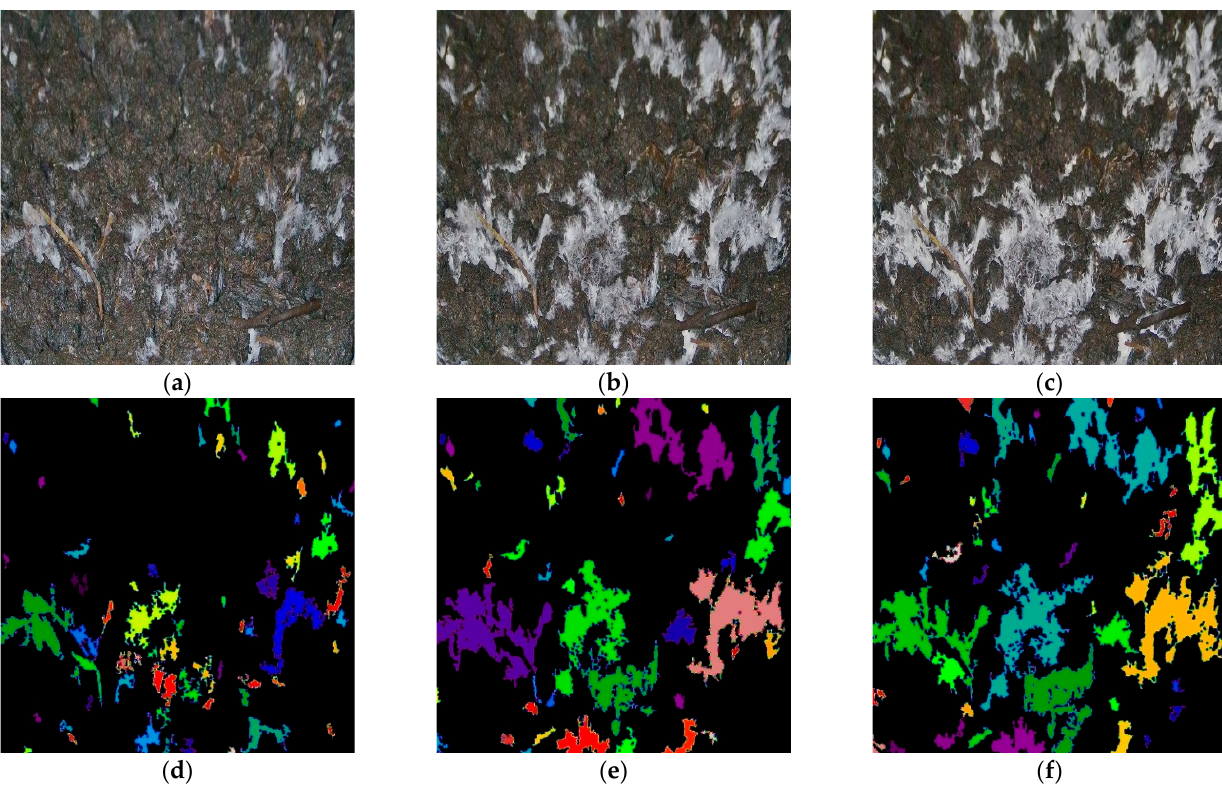
Figure 7. Grayscale images ( a – c ) and connected components of the respective images ( d – f ) on the 5th, 7th, 9th days of the mushroom production cycle.